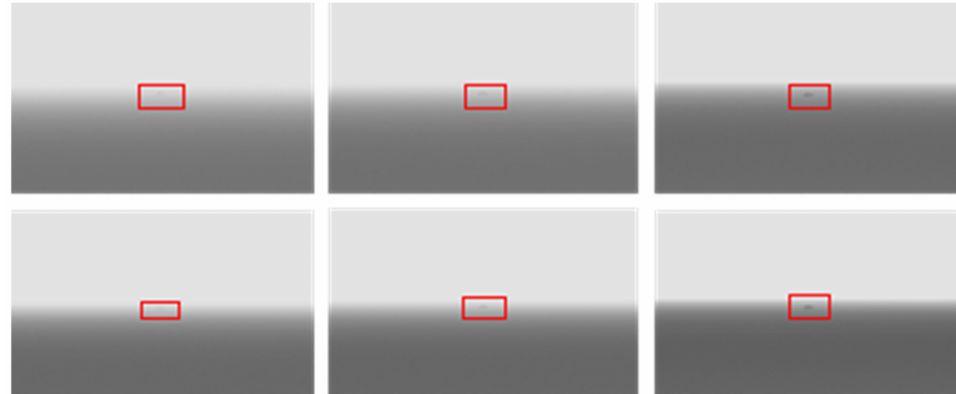
Figure 5. Sample simulation results under typical visibility and detection altitude conditions. The first row of the image represents the simulation results of the platform with a height of 260 m and visibility of 12, 15, and 18 km. The second row of the image represents the simulation results of the platform with a height of 150 m and visibility of 12, 15, and 18